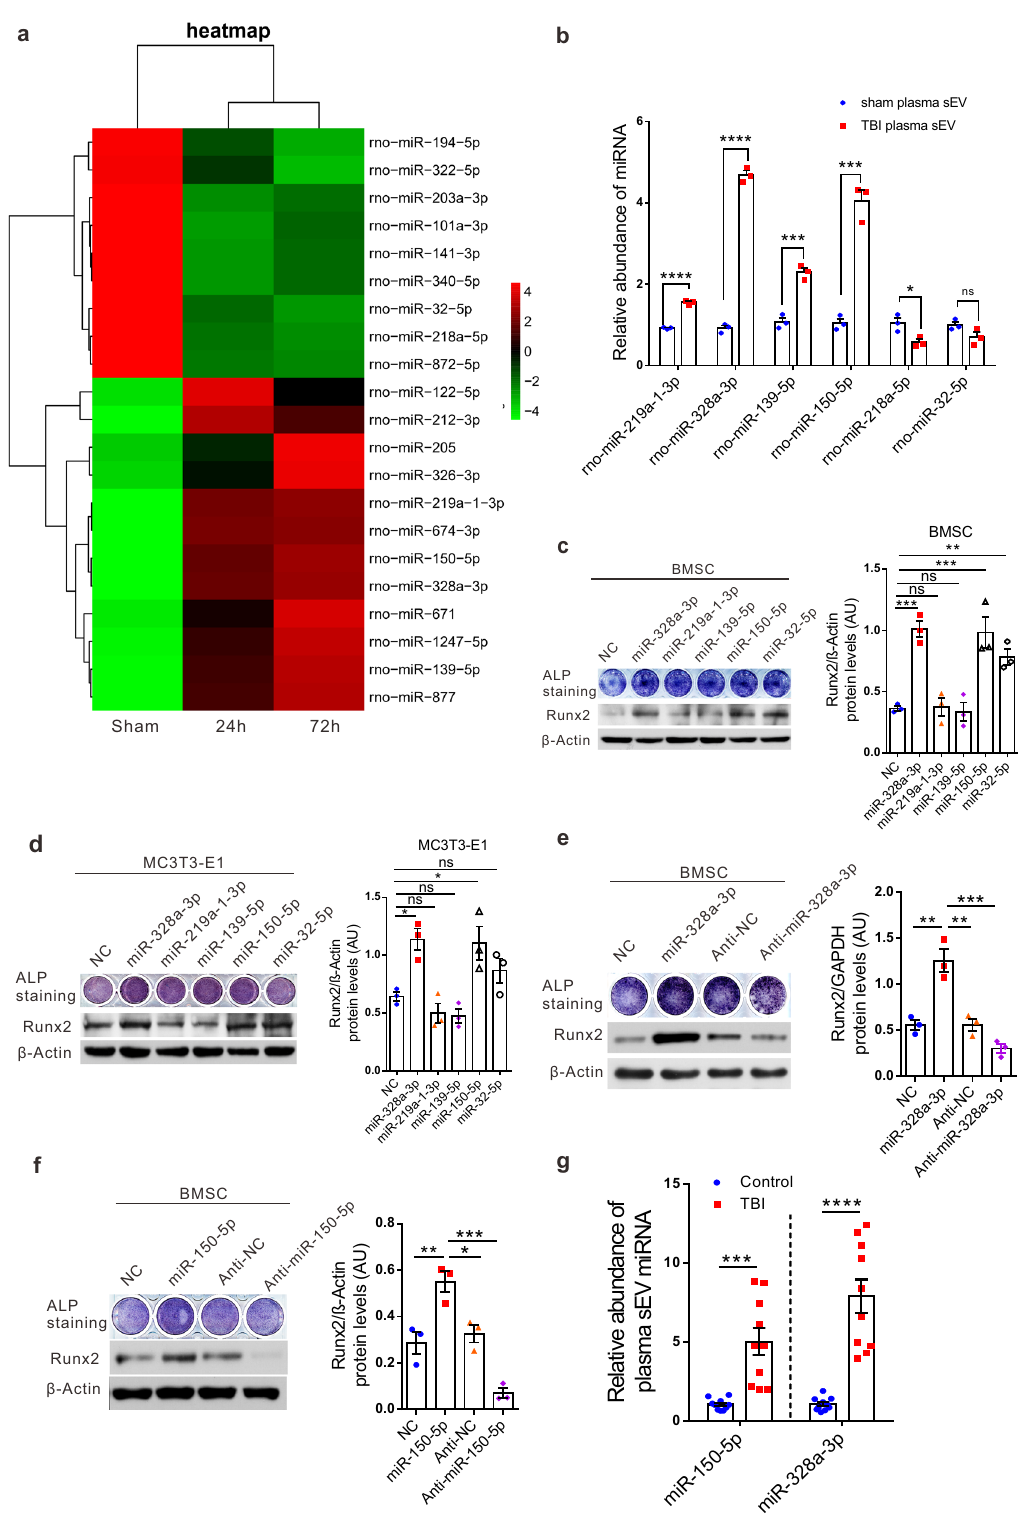
directly targeting FOXO4 and CBL 3 ′ -UTR, respectively . To identify the targets of miR-328a-3p and miR-150-5p, fi rst, we